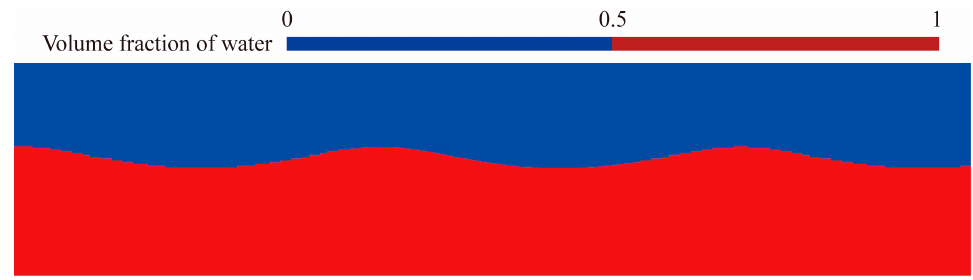
Figure 11. The waveform of numerical wave propagation after 20 s.